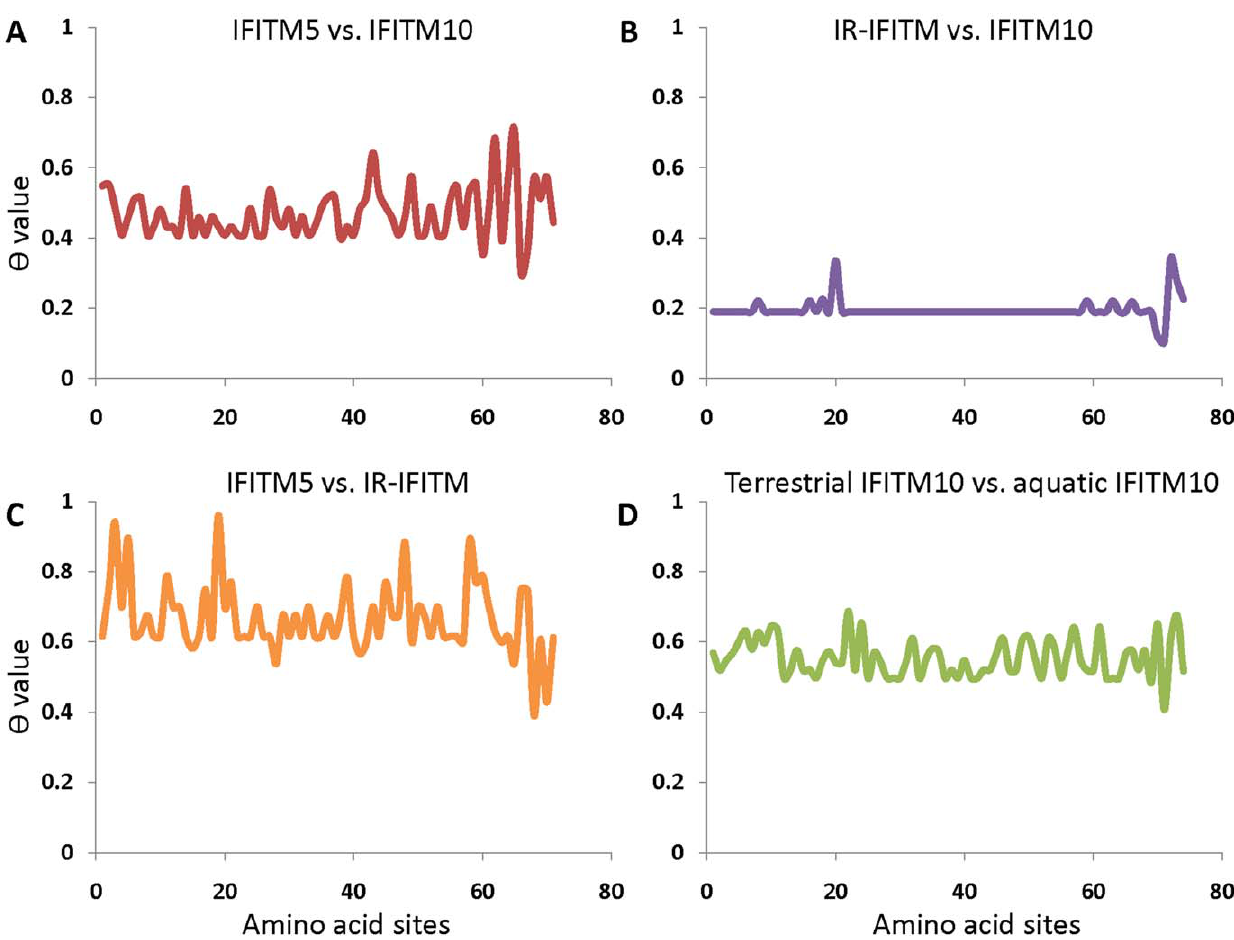
Figure 5. Functional divergence of the vertebrate IFITM families. Estimate of functional divergence was performed in the conservative region (CD225 domain). The X-axis stands for IFITM amino acids position and the Y-axis represents the values of h , which indicates the level of functional divergence. ( A ) IFITM5 vs. IFITM10; ( B ) IFITM10 vs. IR-IFITM; ( C ) IFITM5 vs. IR-IFITM; ( D ) terrestrial IFITM10 vs. aquatic IFITM10.